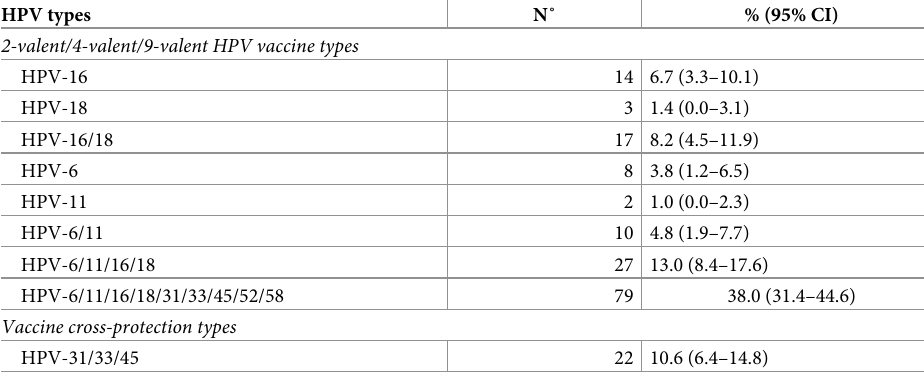
Table 3. Frequencies of vaccine-preventable HPV types in young women (N =